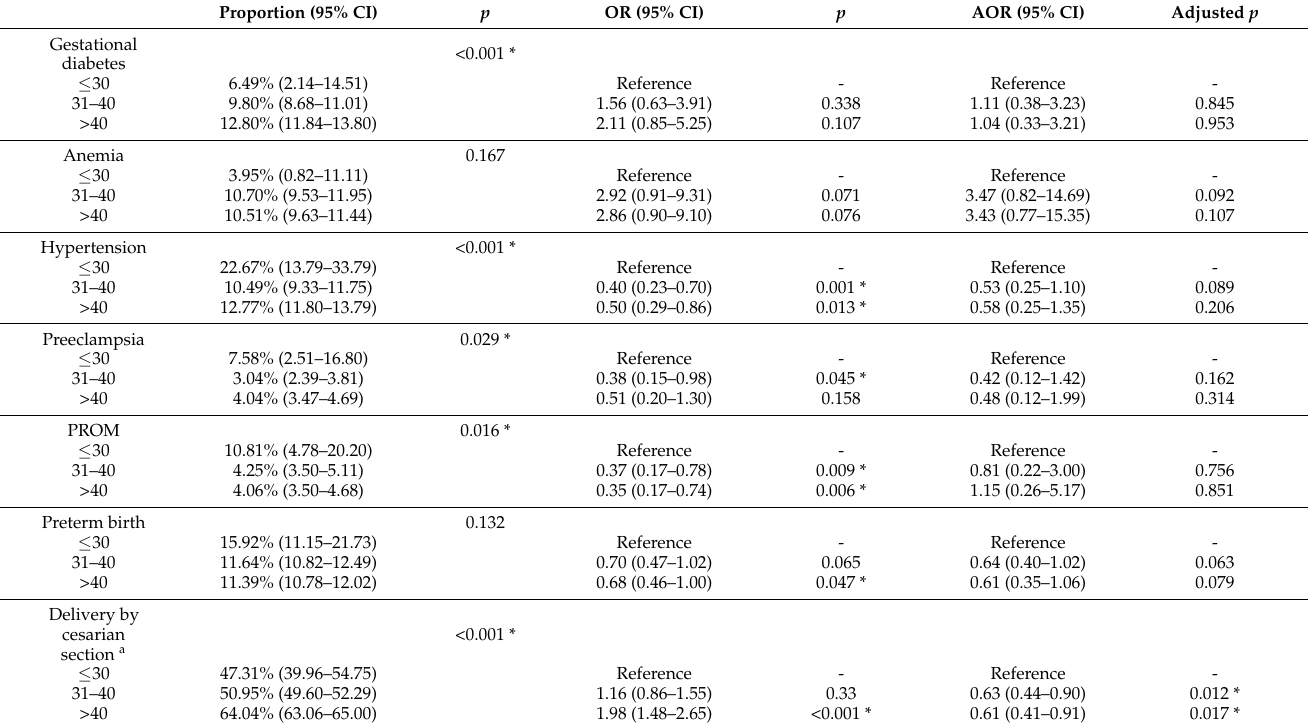
Table 2. Obstetrical outcomes associated with paternal age following in vitro fertilization or intracy- toplasmic sperm injection using autologous sperm and donated